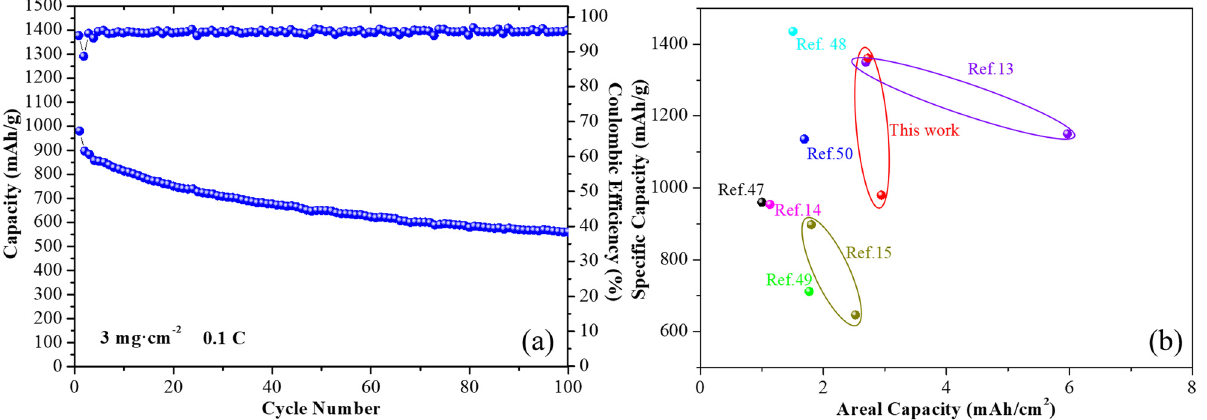
Figure 8: ( a ) Cycling performance of S/Bent@C electrode with a sulfur loading of 3 mg cm − 2 at 0.1C. ( b ) Areal capacity and speci fi c capacity comparisons between the Li – S battery in this work and recently reported Li – S batteries based on clay host materials [ 13 – 15,47 – 50 ]